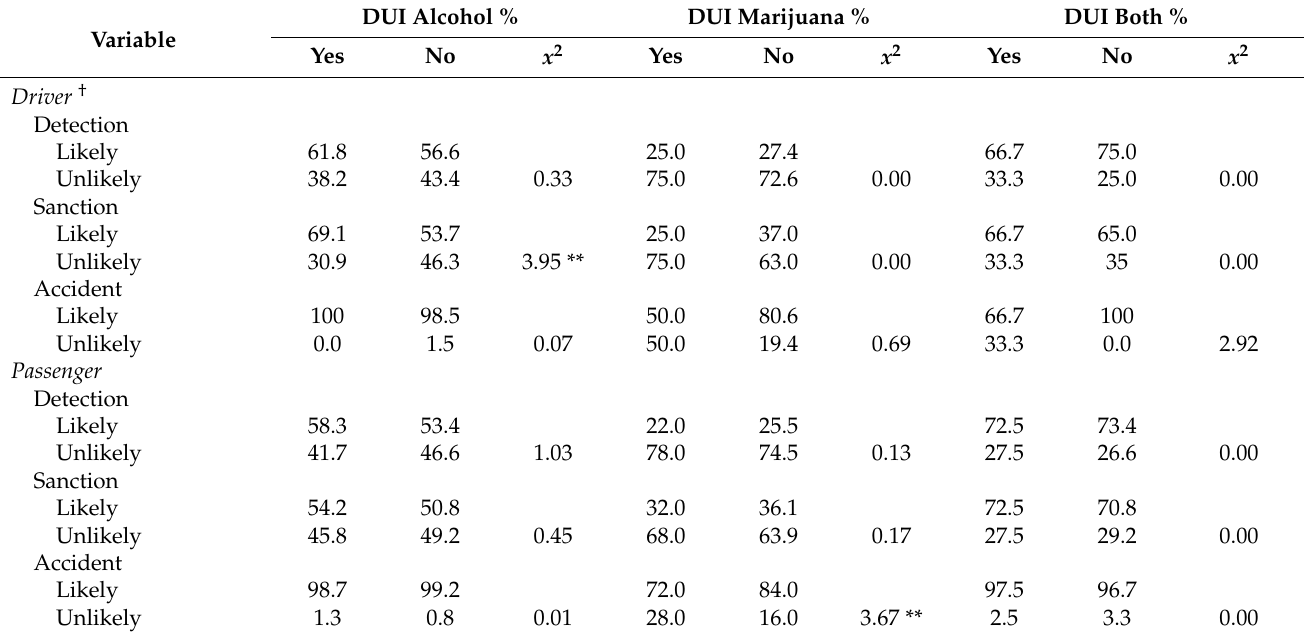
Table 4. Risk perception and DUI-related behaviors